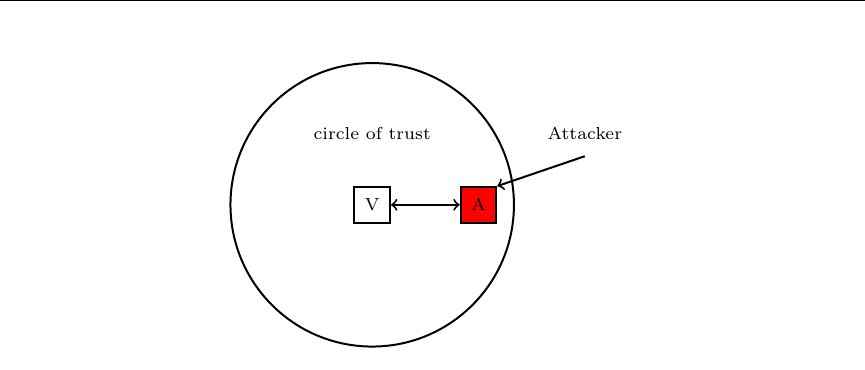
Figure 6: Impersonation attack. Note that there is no prover present in this attack, and that the attacker could also be outside the circle of trust.